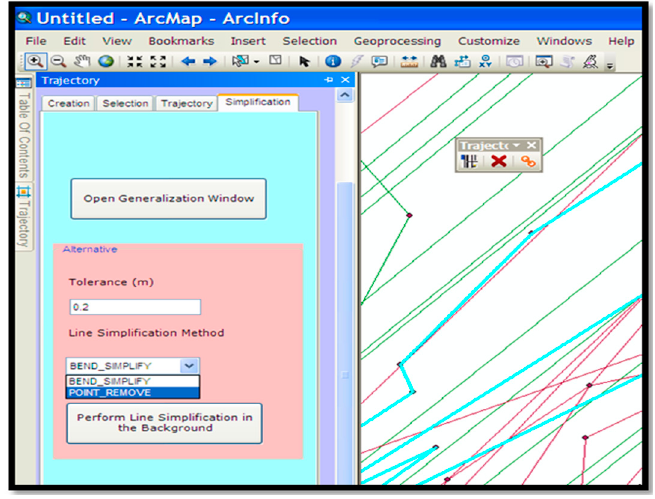
Figure 8. Simplification tab based on the extended Douglas–Peucker algorithm.